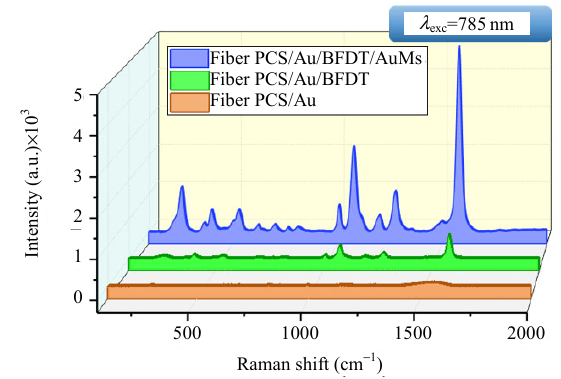
Fig. 4 Proofs of plasmonic coupling − SERS spectra measured on the pristine fibers with bare Au, Au surface with grafted with BFDT and Au grafted with BFDT and then with AuMs